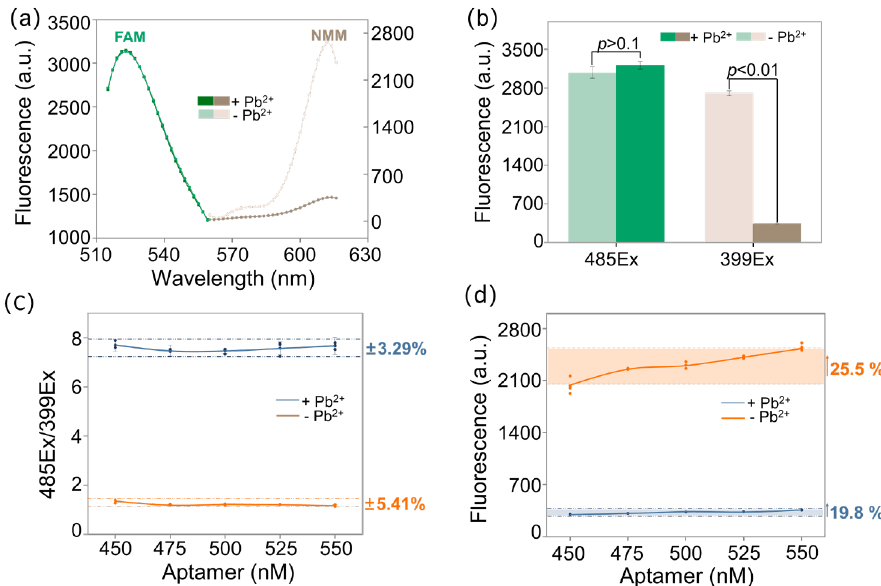
Figure 2. Principle verification and robustness of the ratiometric assay. ( a ) Fluorescent spectra of the aptasensor. ( b ) Fluorescent intensity histogram in the presence and absence of Pb 2+ , respectively. ( c ) Robustness of the G-quadruplex probes. 450, 475, 500, 525, and 550 nM aptamer were tried, respectively. 485Ex/399Ex was the ratio of fluorescent intensity collected at 521 nm (485 nm excitation) to fluorescent intensity collected at 612 nm (399 nm excitation). ( d ) Corresponding fluorescent intensity of ( c